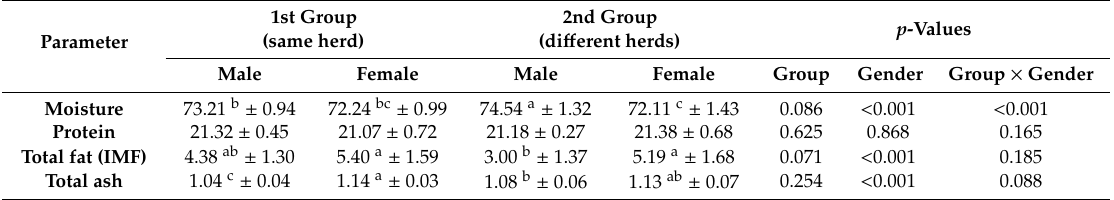
Table 4. Proximate composition (%) of fresh M. longissimus lumborum from investigated groups of Simmental